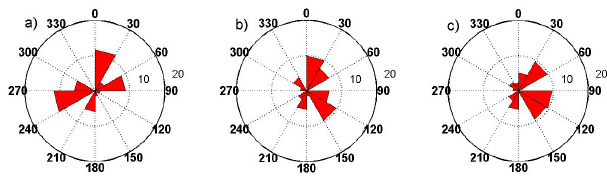
Figure 8. Direction of propagation of gravity waves, (a) for the 34 waves observed in NLC using the camera in TRD, (b) traced from 5 to 80km, and (c) traced from 60 to